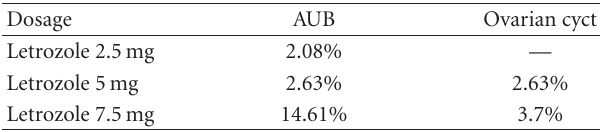
Table 3: Complication of letrozole in step-up protocol.